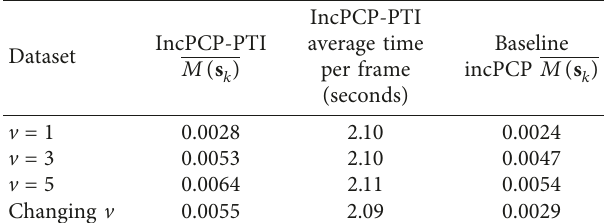
Figure 2: Value of distance δ between binary mask and ground truth frames for incPCP-PTI on the SP dataset (Section 4.1). This figure is a slightly modified version of Figure 2 in [28]. Table 1: Value of average distance M ( s ) between binary mask and k ground truth frames for incPCP-PTI and baseline incPCP on the SP dataset (Section 4.1). Computational time per frame for incPCP- PTI is also